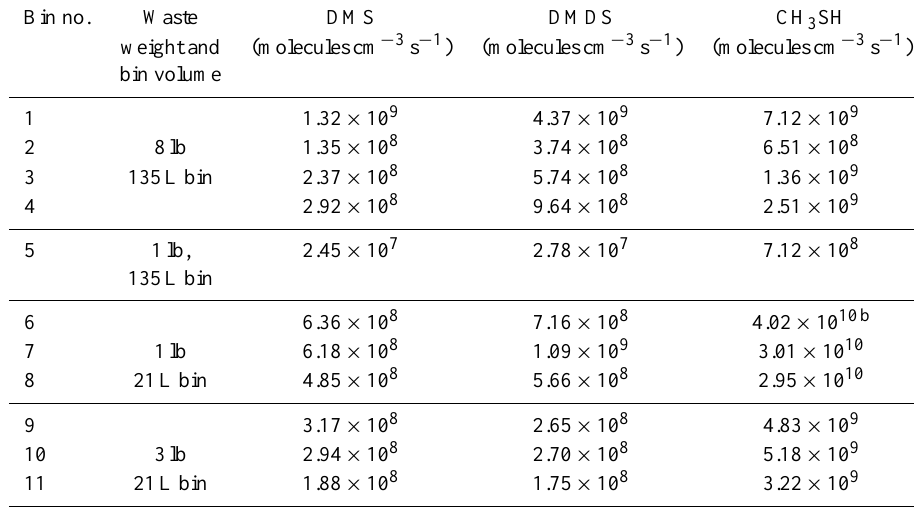
Table 3. Emission rates from bins for DMS, DMDS, and MTO determined by PTR-ToF-MS in moleculescm − 3 s − 1 a . Bin